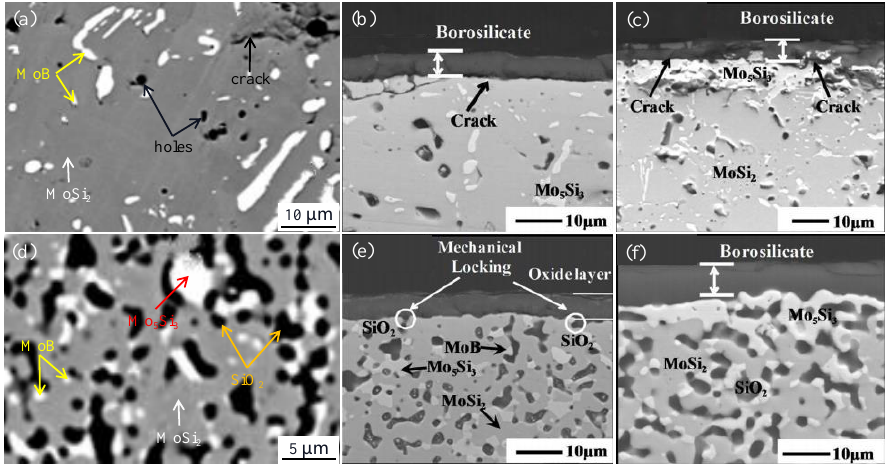
Figure 6. BSE micrographs: SPS-MD ( a ), SPS-BM ( d ); Cross-sectional micrographs of SPS-MD and SPS-BM oxidized at different temperatures for 30 h: 1250 °C ( b , e ); 1350 °C ( c , f ). Reproduced with permission [50]. Copyright 2017 Elsevier.